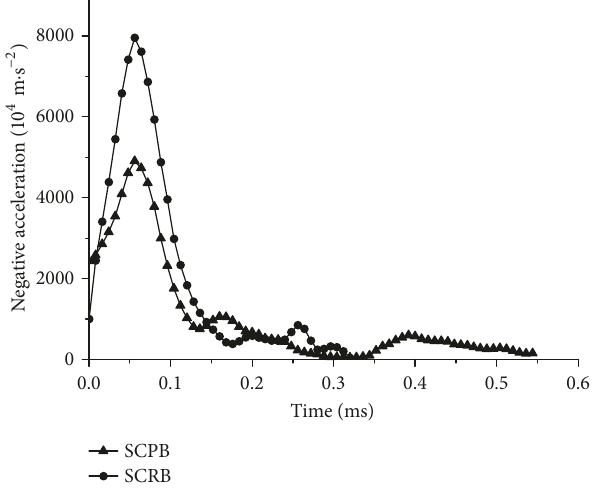
Figure 20: Negative acceleration of SCPB and SCRB.